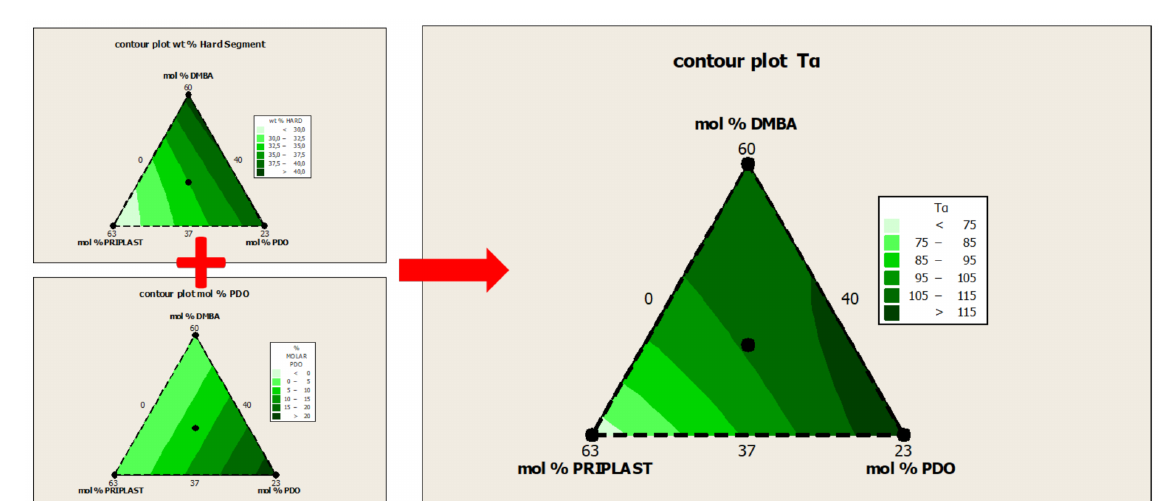
Figure 11. Contour plots obtained by Minitab software from the ternary mixture experimental design. ( Left ) ( up ): contour plot of Hard segment content in wt. %. ( Left ) ( down ): contour plot of 1,3-PDO content in mol %. ( Right ): contour plot of relaxation temperature ( T α ).